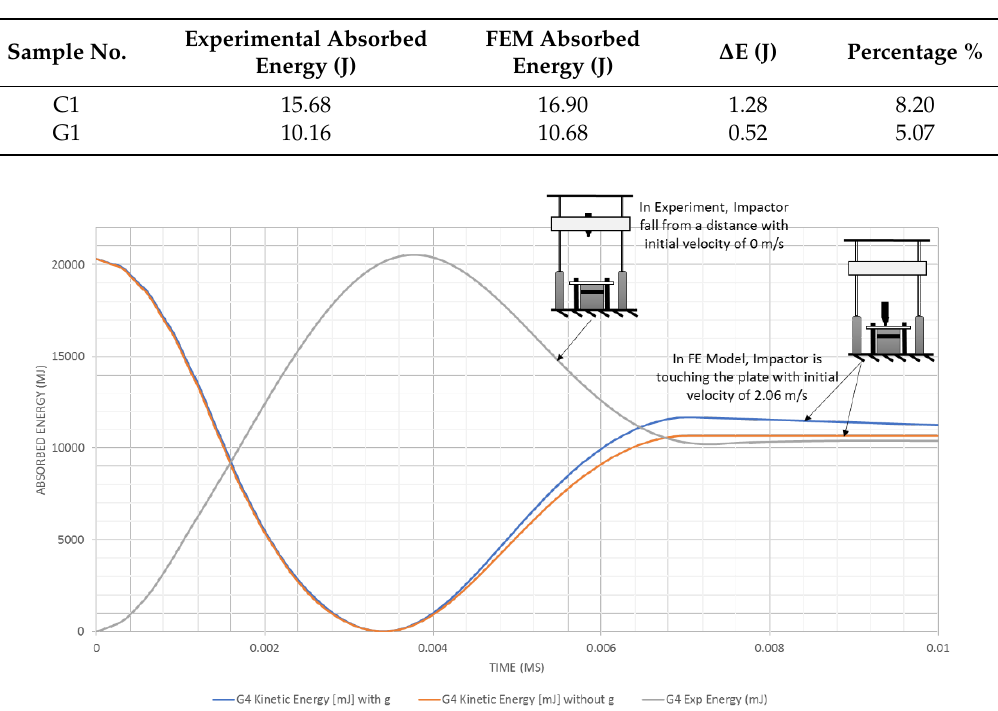
Table 10. Summary of the experimental results for high-performing cases with high absorbed energies.